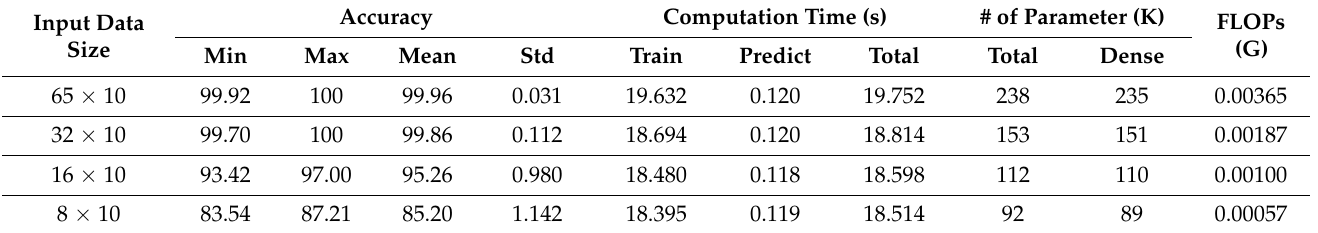
Table 6. Comparison of bearing fault diagnosis accuracy performance and computation complexity measures (computation time, number of parameters, and Flops) of lite CNN models using each input data size according to each corresponding sample rate.